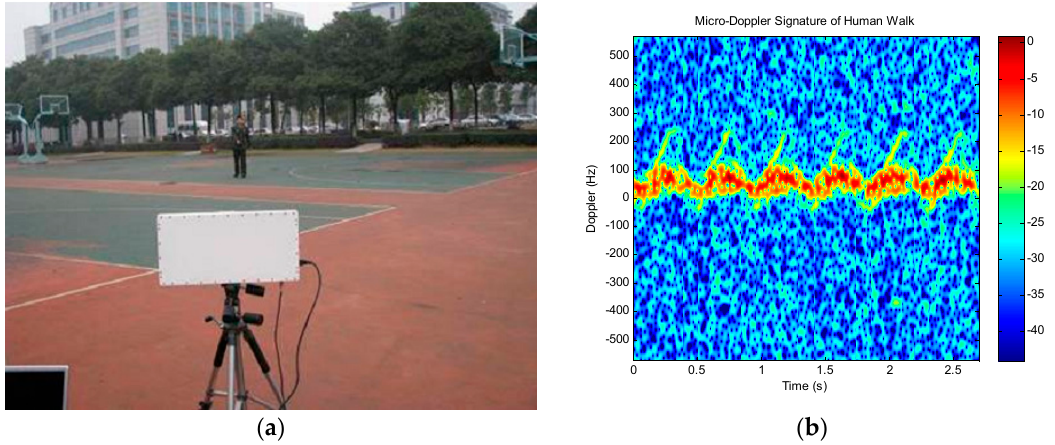
Figure 10. Walking human: ( a ) the setup of experiment; ( b ) TFD of the micro-Doppler signals.